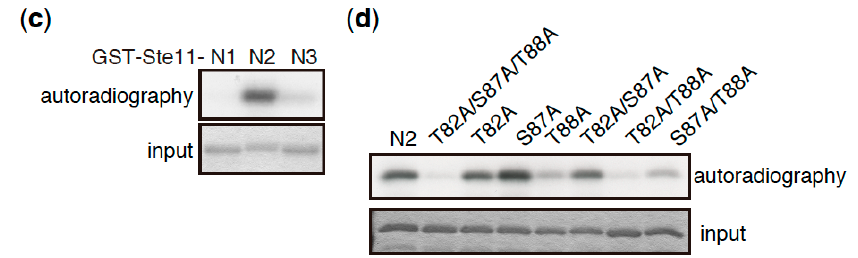
Figure 3. Ste11 is phosphorylated by TORC1. ( a ) Schematic illustration of truncation series of Ste11 used in in vitro kinase assays. HMG represents a DNA binding domain, HMG (high mobility group) box. ( b – d ) In vitro phosphorylation of Ste11 by TORC1. Flag ‐ tagged Tor2 was immunoprecipitated from S. pombe cell extracts using an anti ‐ FLAG antibody. The same immunoprecipitation conditions